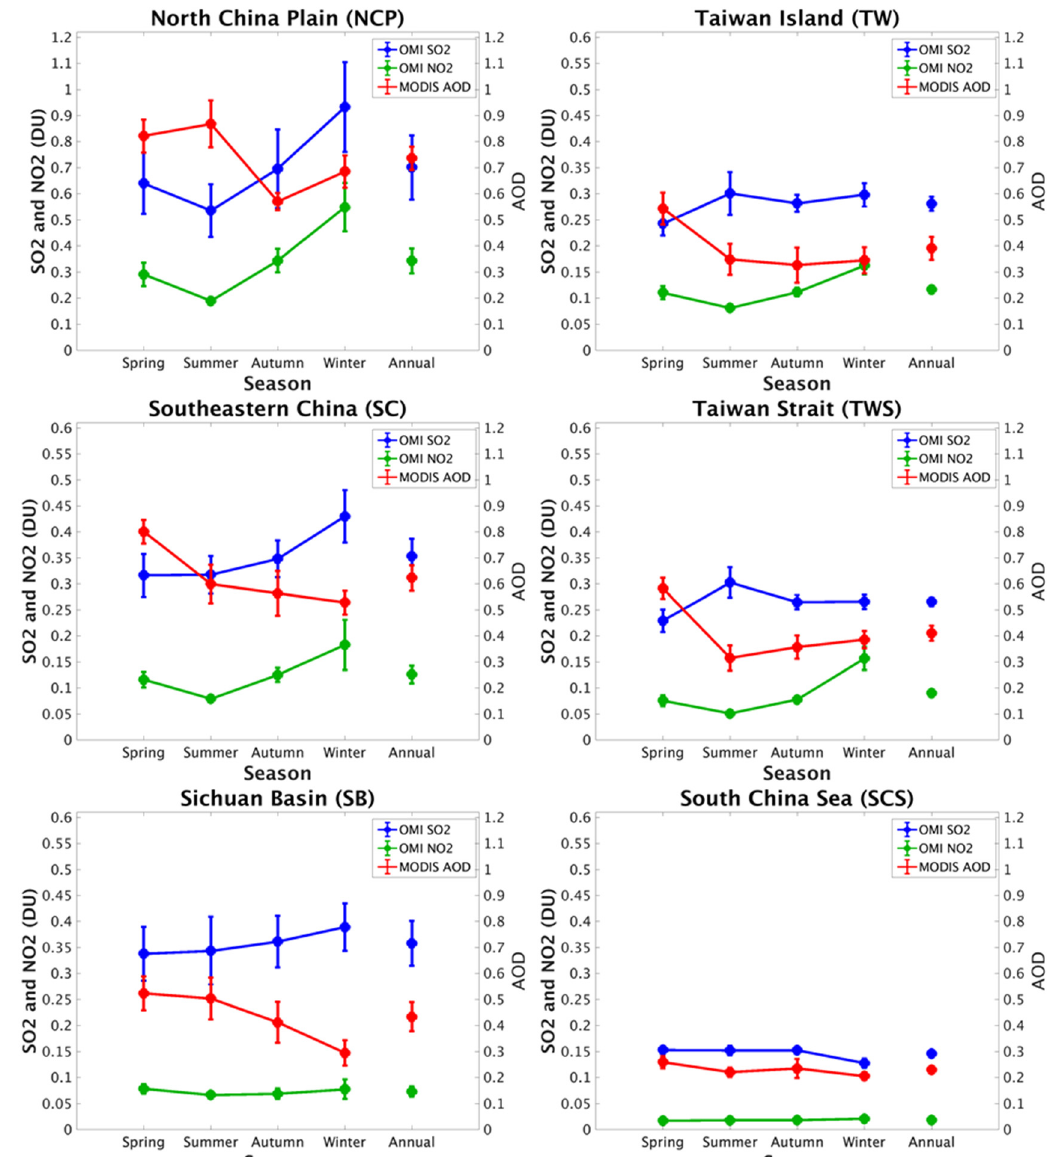
Figure 7. Seasonal cycle of SO 2 , NO 2 , and AOD for each monitoring region. The error bar indicates the standard deviation of each seasonal or annual mean. Note that the scale of SO 2 and NO 2 for the NCP is different from that for the other regions.